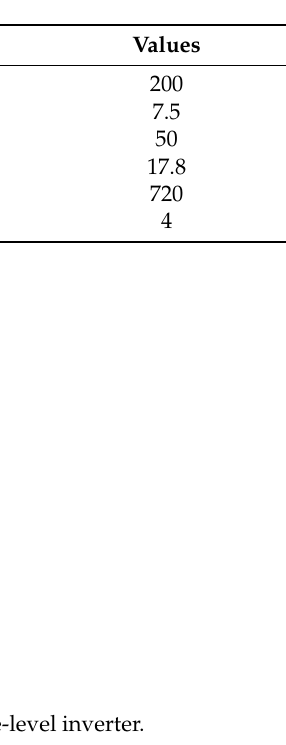
Table 4. Experimental parameters.